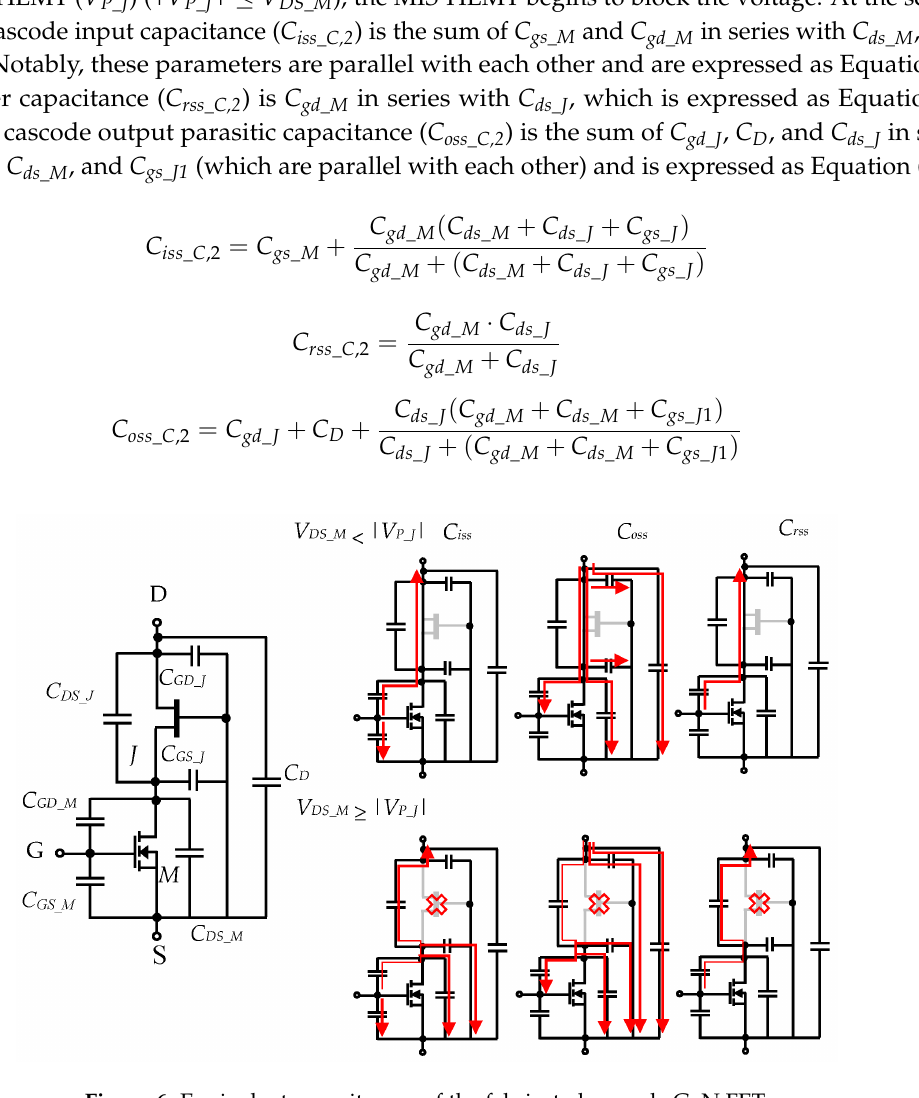
Figure 6. Equivalent capacitances of the fabricated cascode GaN FET.